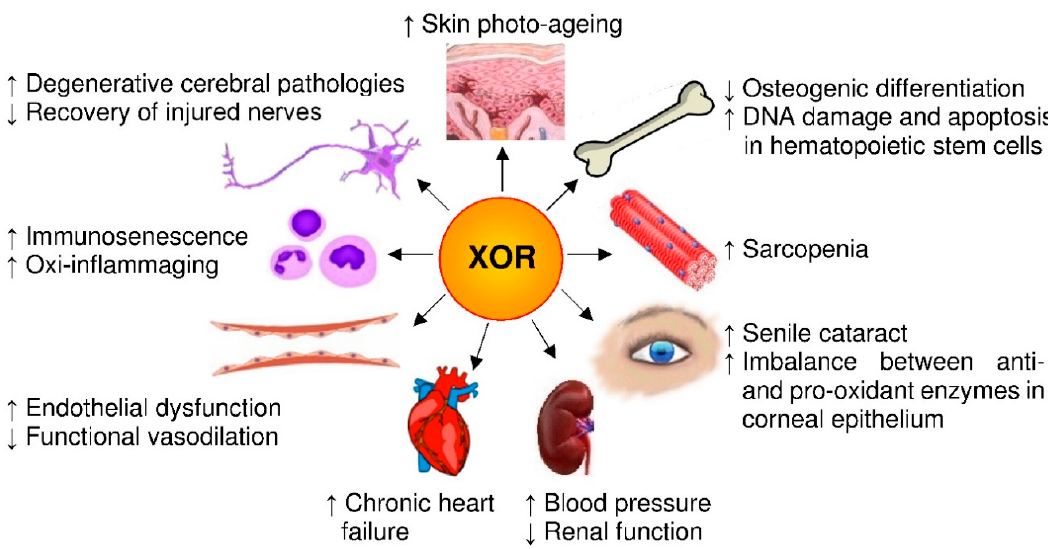
Figure 4. Pro-aging e ff ects of xanthine oxidoreductase (XOR) products. Senescence is associated with an XOR-dependent oxidative stress that a ff ects the cells of many organs and systems, as exemplified in the image. In addition, this pro-oxidant state contributes to the formation of advanced glycation end-products, thus aggravating the conditions of diabetic